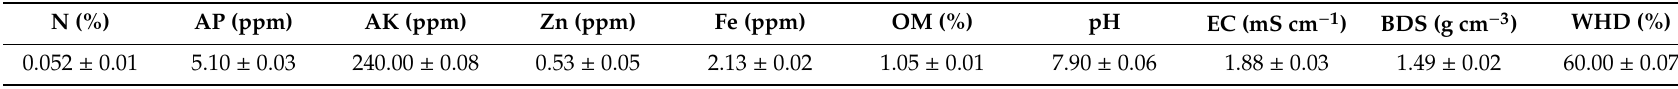
Table 1. Physio-chemical parameters of soil before sowing of wheat crop.